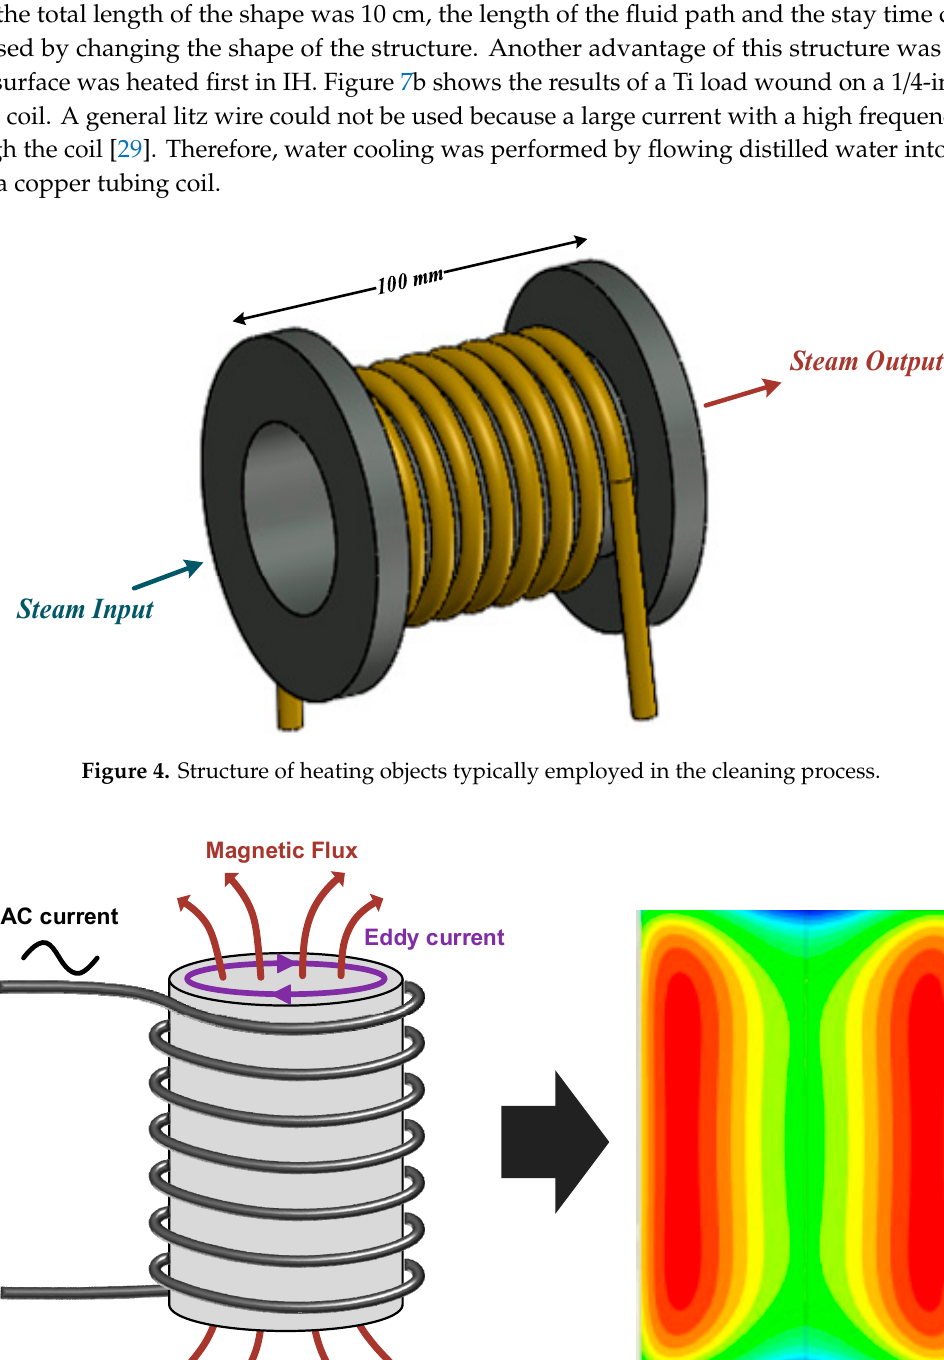
Figure 4. Structure of heating objects typically employed in the cleaning process.